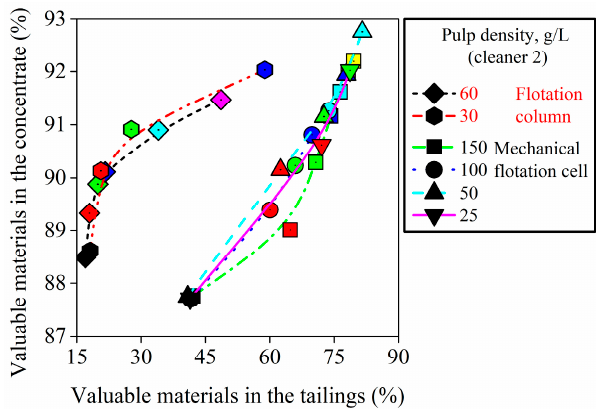
Figure 7. Comparisons of flotation separation efficiency between the mechanical flotation cell and flotation column.